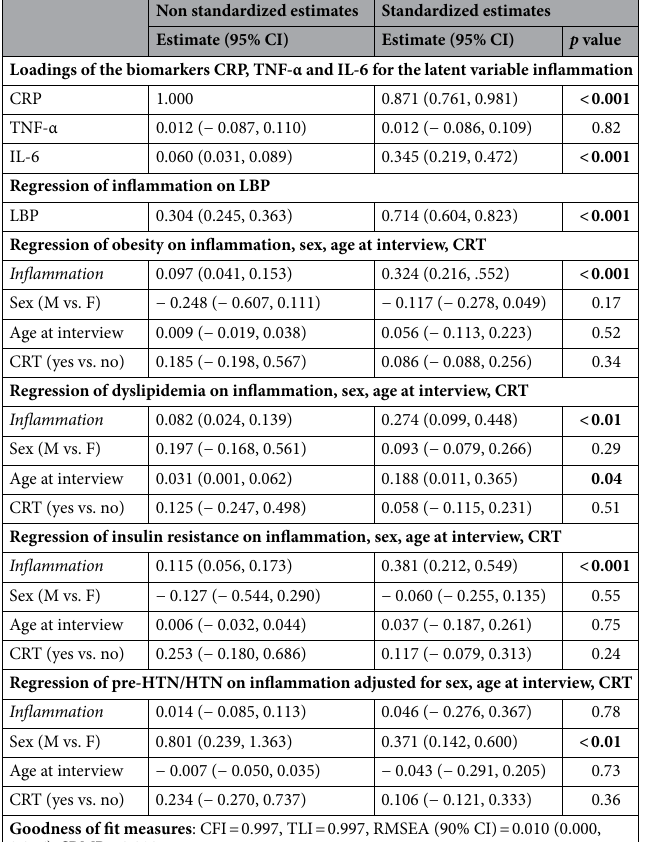
Table 7. SEM estimates of the associations between LBP, inflammation , obesity, dyslipidemia, insulin resistance and pre-HTN/HTN. CRT: cranial radiotherapy; CFI: Comparative Fit Index; HTN: hypertension; LBP: LPS binding protein; RMSEA: Root Mean Square Error of Approximation; SRMR: Standardized Root Mean Square Residual; TLI: Tucker-Lewis Index. p values of non-standardized estimates are not shown as they are almost identical to p values of standardized estimates.